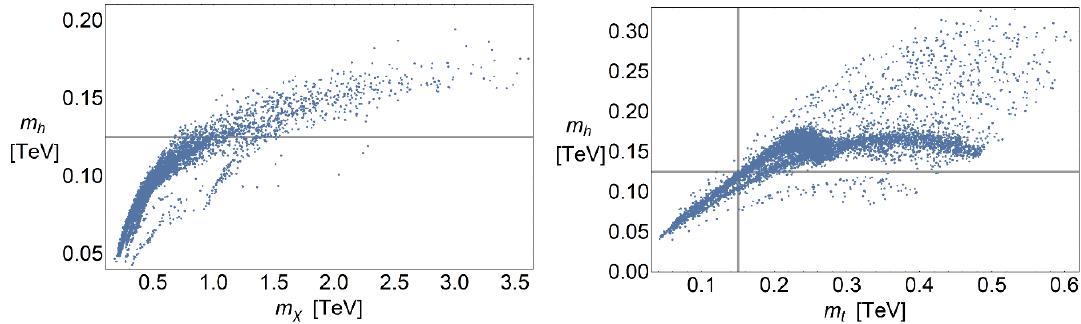
Figure 1 . Left panel: h and (cid:31) masses, with a random scan of parameters as explained in the text, re-scaling the dimensionful quantities to (cid:12)x v = 246 GeV. Right panel: Higgs and top quark masses, with a random scan, (cid:12)xing f 0 = 1 TeV. The gray lines correspond to m h = 125 GeV and m t = 150